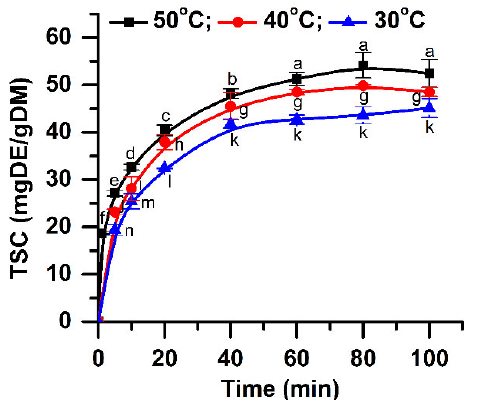
Figure 2. Influence of extraction time and temperature on the TSC (extraction conditions: a plant material to solvent ratio of 1:20 (w:v), continuous sonication, an ethanol concentration of 96%). Data were analyzed using one-way ANOVA ( p < 0.05). Different letters (a–n) within graph shows the significant difference between groups.